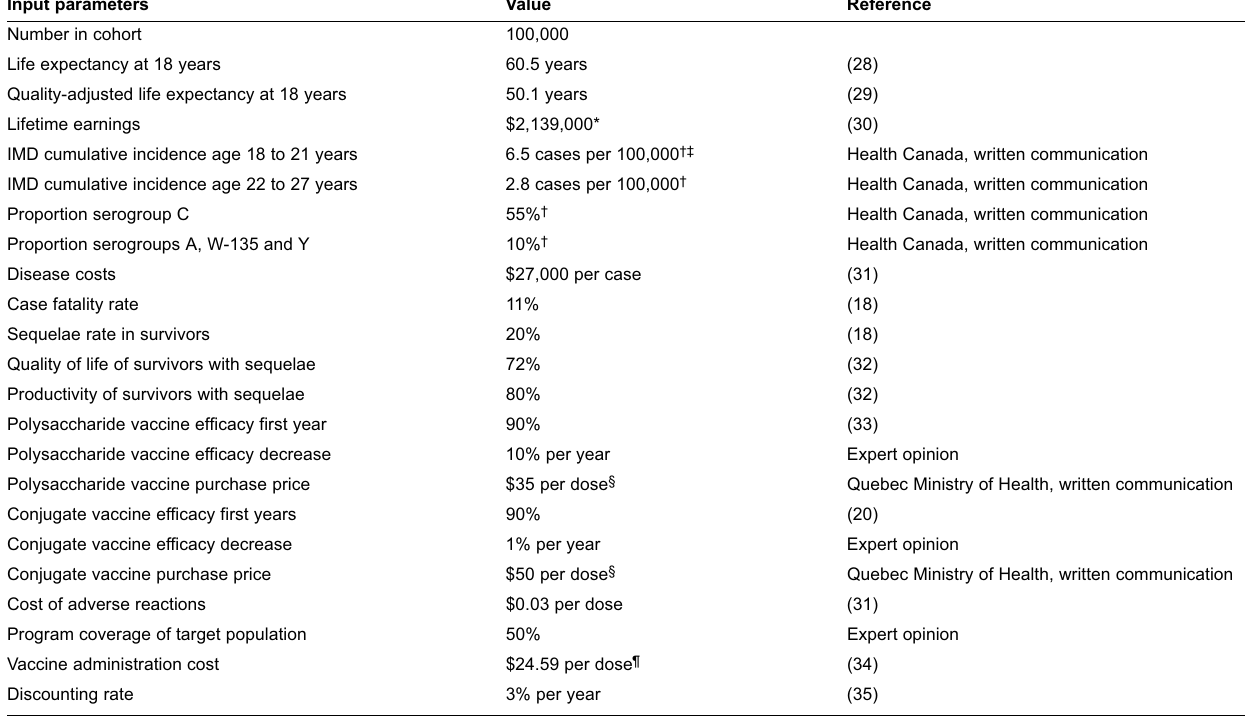
TABLE 1 Values of input parameters in base